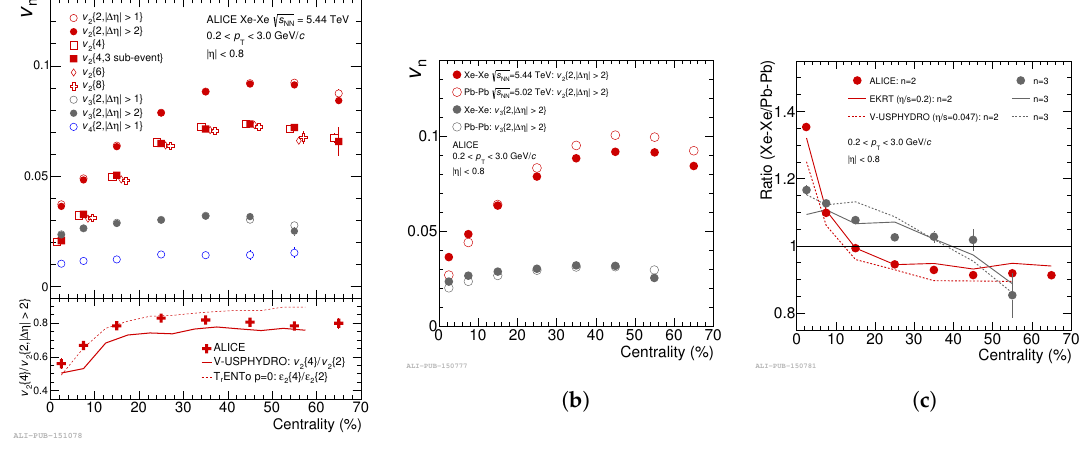
Figure 1. ( a ) Upper panel: v n { m } , 2 ≤ n ≤ 4, as a function of centrality in Xe–Xe collisions at 5.44 TeV, for various orders m and pseudorapidity gaps. Lower panel: Comparison of the ratio v 2 { 4 } / v 2 { 2, | ∆ η > 2 |} with a hydrodynamic calculation where a T R ENTo IS model has been propagated using V-USPHYDRO [6,7]. The results are also compared with ε 2 { 4 } / ε 2 { 2 } from the IS model. ( b ) Comparison of v n { 2, | ∆ η > 2 |} , n = 2,3, between Xe–Xe and Pb–Pb collisions as a function of centrality. ( c ) Ratios between flow coefficients in Xe–Xe and analogous ones in Pb–Pb as a function of centrality, compared to hydrodynamic calculations from EKRT ( η / s = 0.2) and V-USPHYDRO ( η / s = 0.47) [6,8],